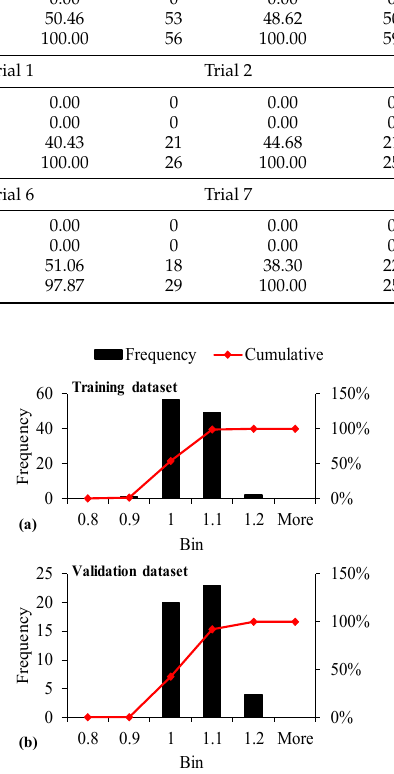
3.2.3. Predicted to Experimental Ratio ( ρ ) A variety of statistical methods are used to investigate the performance of developed